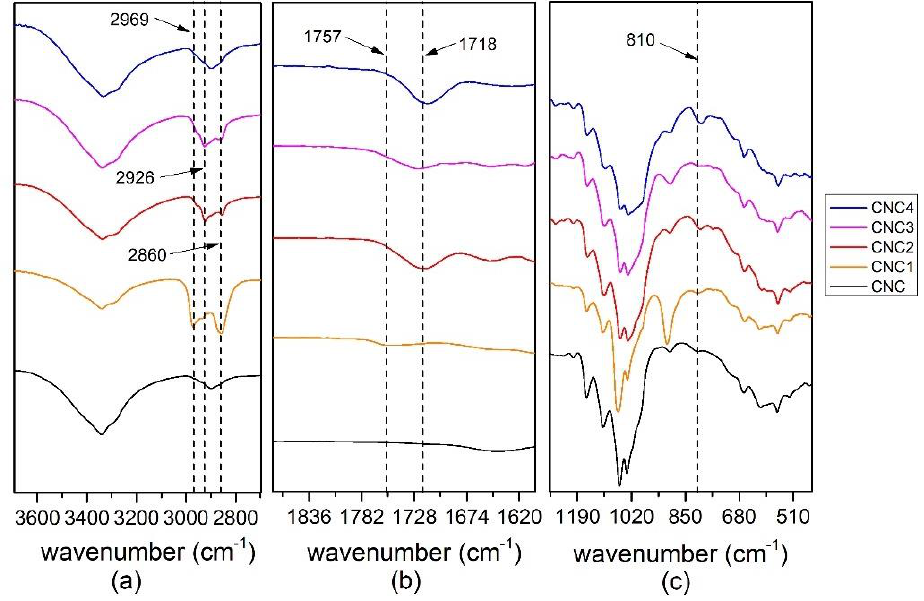
Figure 2. FTIR spectra of the neat CNC and functionalized CNC: ( a ) 3700–2700 cm −1 scale; ( b ) 1870–